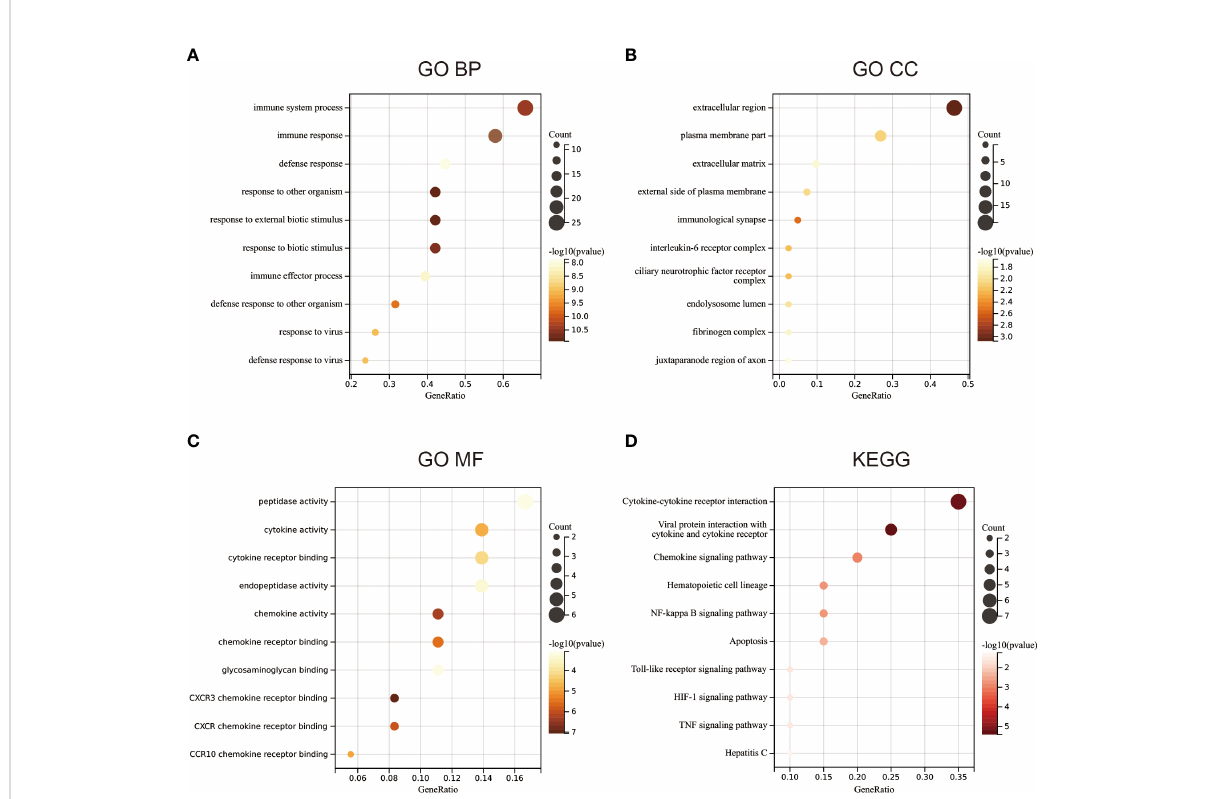
FIGURE 2 Functional enrichment analysis. (A) Gene ontology (GO) enrichment analysis of biological processes. (B) GO enrichment analysis of cellular components. (C) GO enrichment analysis of molecular functions. (D) KEGG functional enrichment